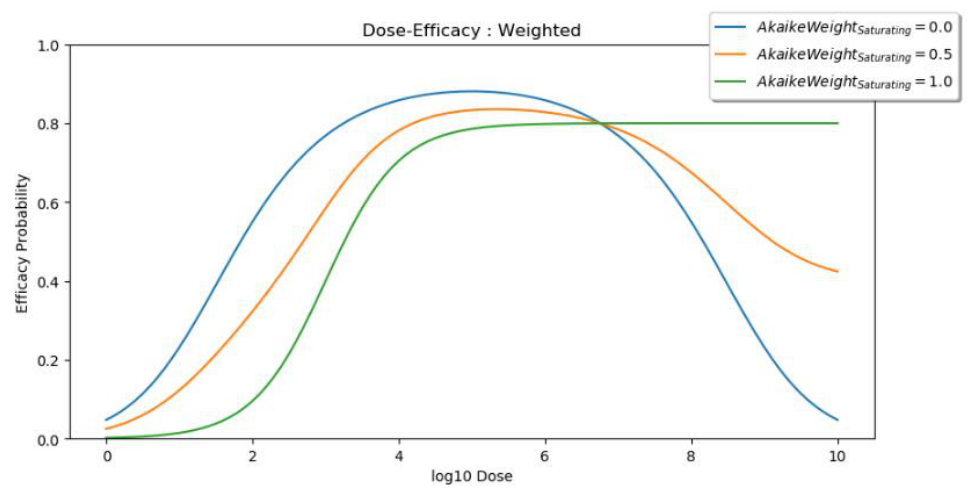
Figure 3. Visual example of model averaging. When the saturating Akaike weight is 0, the predicted efficacy curve is defined entirely by the peaking model (blue). When the saturating Akaike weight is 1, the predicted efficacy curve is defined entirely by the saturating model (green). If both models are equally as likely, given the available data, then the saturating Akaike weight and the peaking Akaike weight are both 0.5, and the predicted efficacy curve is the midpoint of the saturating and peaking curves (orange).